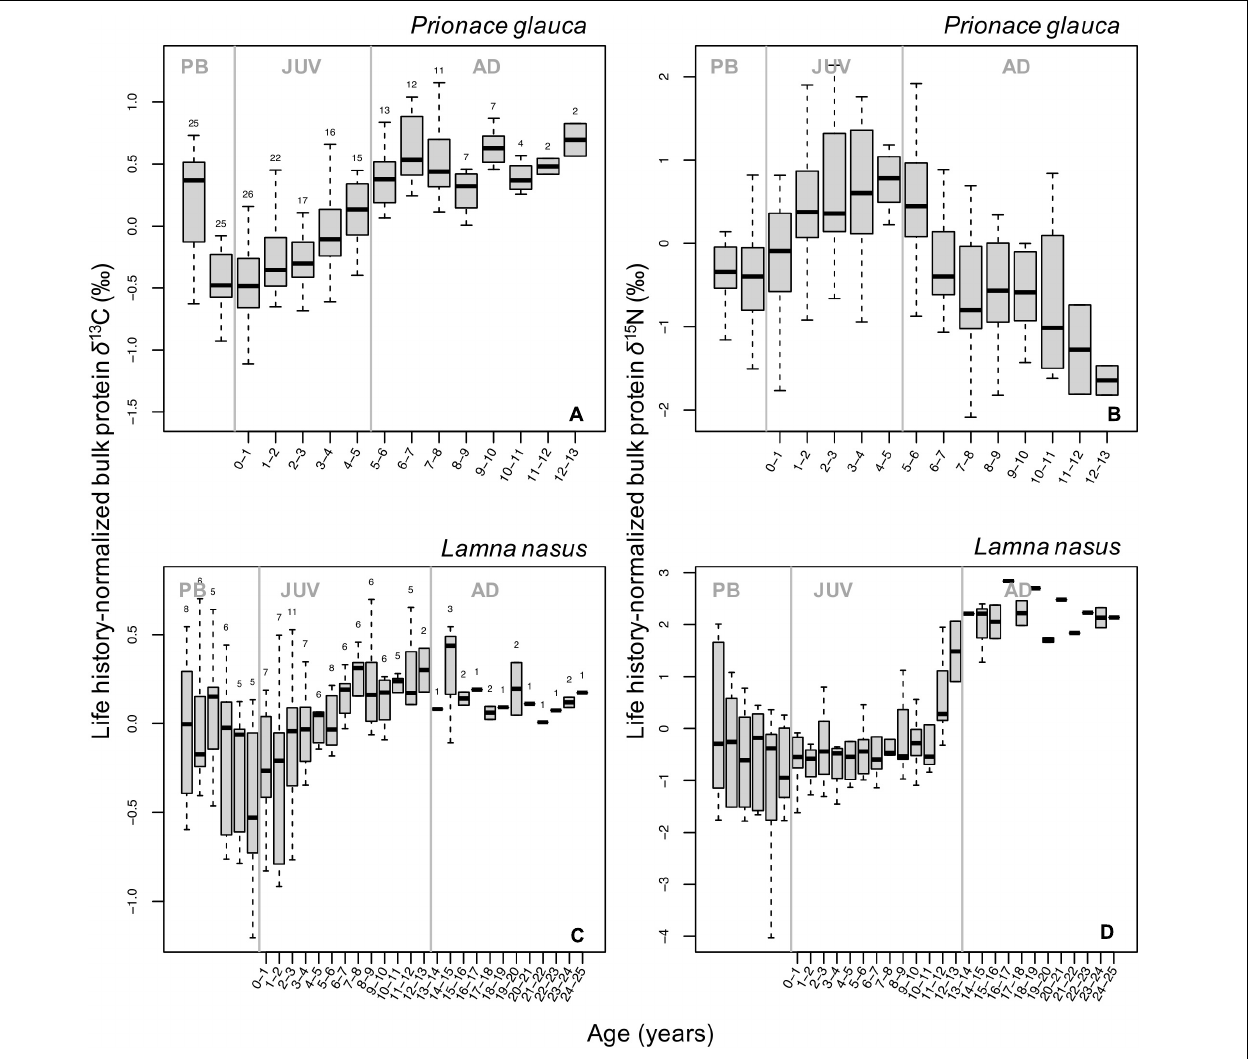
FIGURE 2 | Boxplots of life-history normalized δ 13 C (A,C) and δ 15 N (B,D) values of bulk protein by age class in blue sharks (A,B) and porbeagles (C,D) . Numbers at the top of each boxplot in (A,C) indicate the number of samples analyzed δ 13 C for each age class; the same numbers were analyzed for δ 15 N. Gray vertical lines represent age at birth (0 years) and at maturity (5 and 13 years for blue sharks and porbeagles, respectively) and separate pre-birth (PB), juvenile (JUV), and adult (AD) life-history stages. Age classes are not plotted for samples in the PB stage as Von Bertalanffy growth curves are not applicable to back-calculate age during this